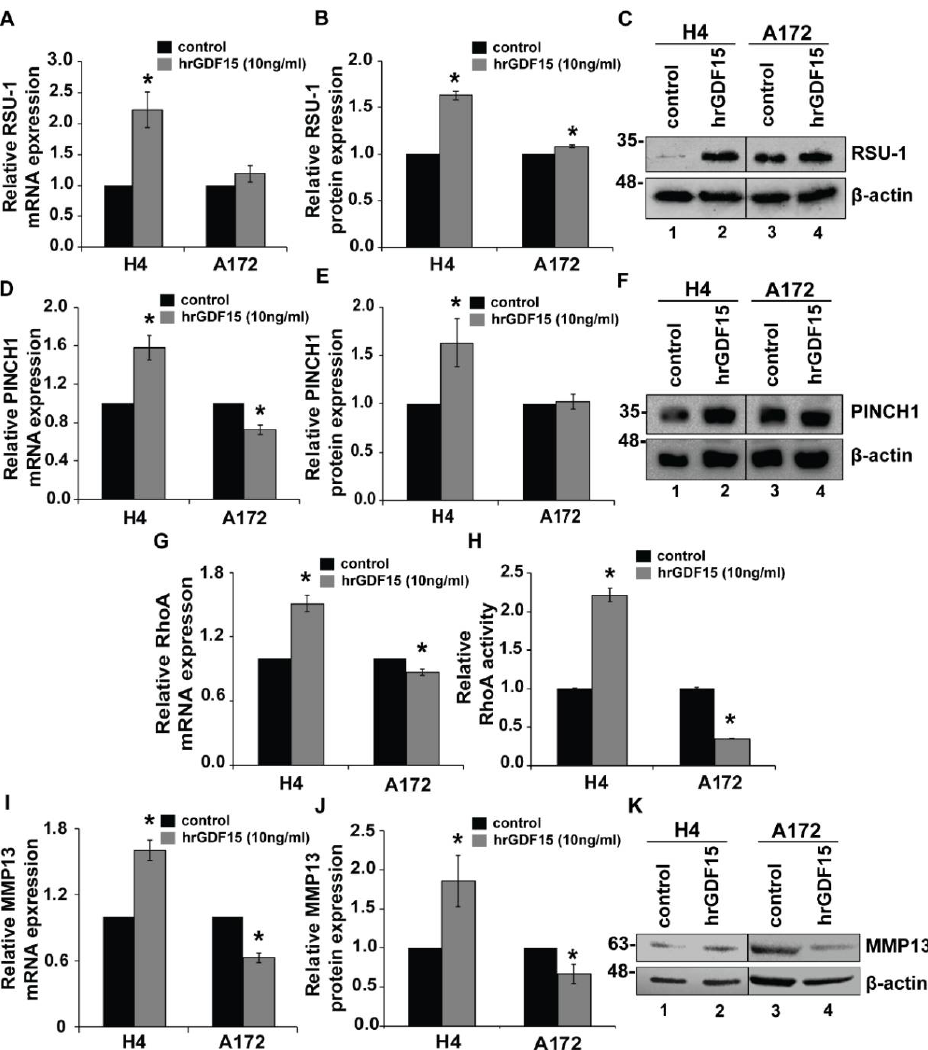
Figure 3. hrGDF-15 treatment upregulates RSU-1 expression and promotes or suppresses invasion of glioma cells through upregulation or downregulation of PINCH1, RhoA, and MMP13 respectively. ( A , D , G , I ) Relative mRNA expression of RSU-1 , PINCH1 , RhoA and MMP13 respectively in H4 and A172 cell line upon treatment with hrGDF15 (10 ng/mL) for 24 h. Four independent real-time PCR experiments were performed and data were analyzed using the ΔΔCt method using control-treated cells as a calibrator sample for each cell line. ( H ) Relative RhoA activity 24 h post rhGDF15 treatment on H4 and A172 cell lines. ( B , E , K ) Representative pictures of Western blot displaying RSU-1, PINCH1 and MMP13 protein expression following hrGDF15 treatment for 24 h. ( C , F,J ) Graphs representing quantification of RSU-1 and PINCH1 protein expression respectively for each cell line using ImageJ software and β-actin as loading control. Mean band intensity from two immunoblots from independent experiments was used for the quantification. Asterisks indicate a statistically significant difference ( p < 0.05) compared to control data.